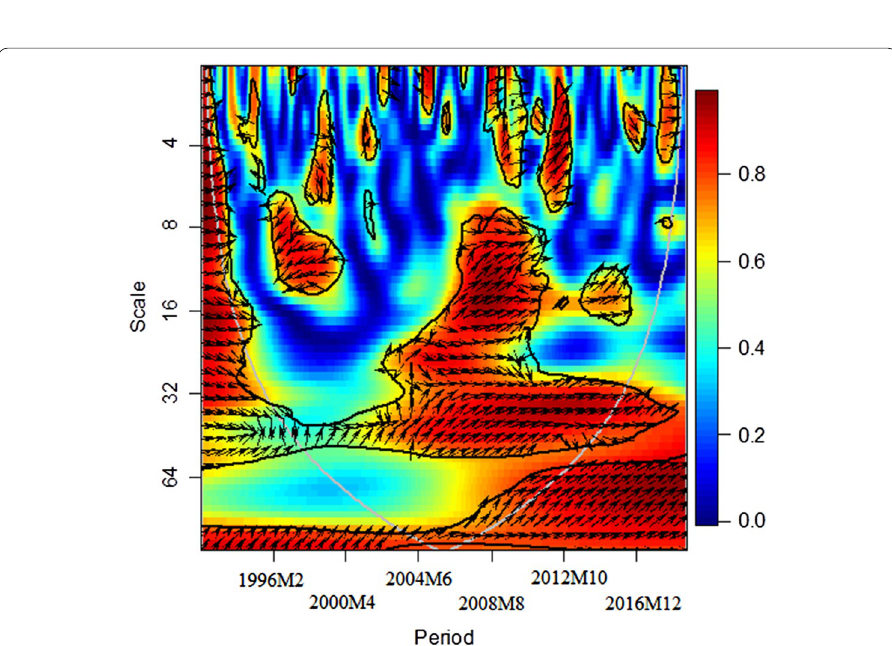
Fig. 6 Wavelet coherence between energy price index and agricultural raw materials